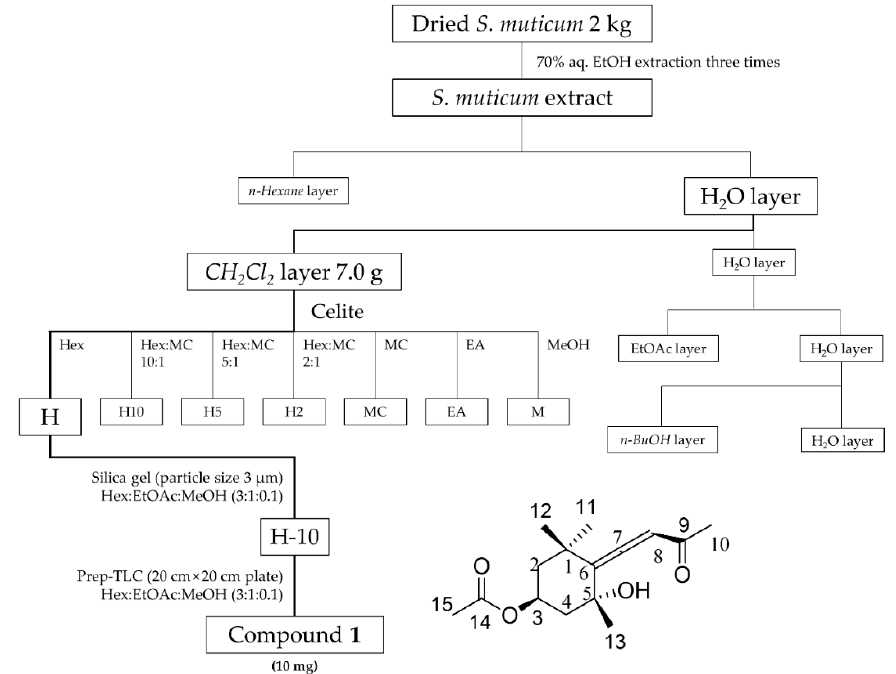
(cid:48) -fucoxanthinone isolated from S. muticum Figure 9. Apo-9 ′ -fucoxanthinone isolated from S. muticum extract. Figure 9. Apo-9